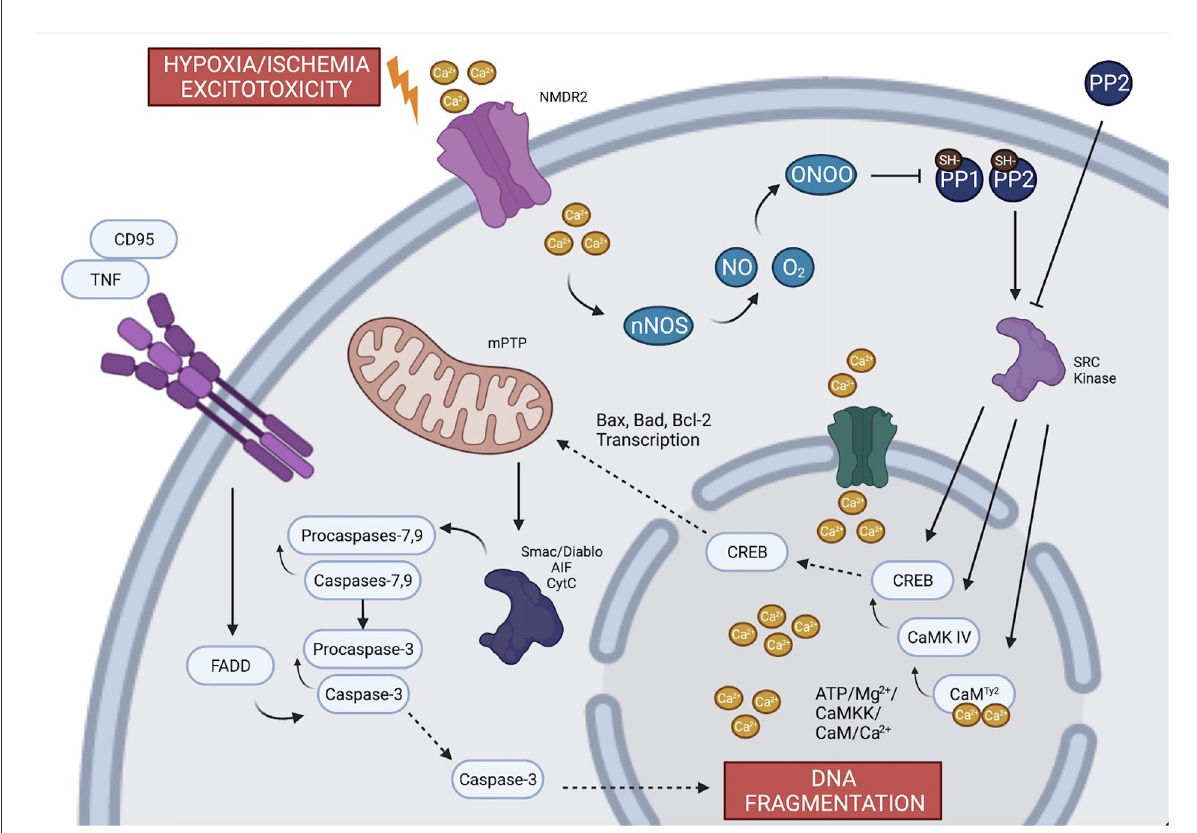
FIGURE2 The proposed mechanism of the apoptotic pathway in a developing neuron. During global ischemia, evidence suggests that the three major mechanisms of neuronal cell death (excitoxicity, generation of free radicals and inflammation) are mediated through the phosphorylation of regulatory sites by Src kinases. Failure of the oxidative phosphorylation gives rise to intracellular Ca 2 + which triggers ecotoxicity and potentiates calcium-dependent apoptotic pathways. Calcium contributes to the generation of free radicals through NO and nNOS and leads to transcription of factors that induces leakage of apoptotic proteins from mitochondria. The inflammation and the extrinsic apoptotic pathway are mediated through TNF and different types of caspases. Created with